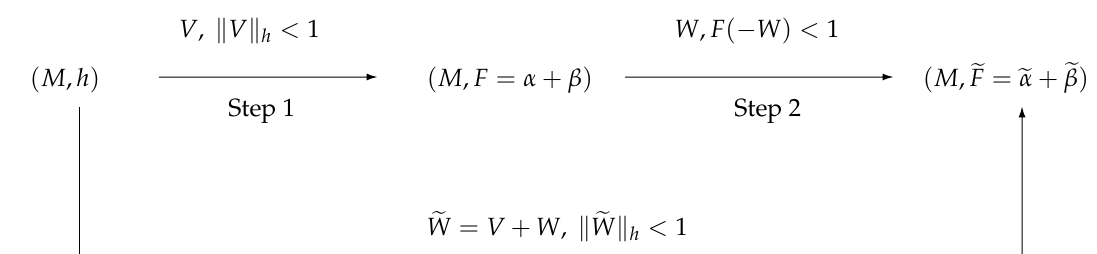
Figure 2. The two steps Zermelo’s